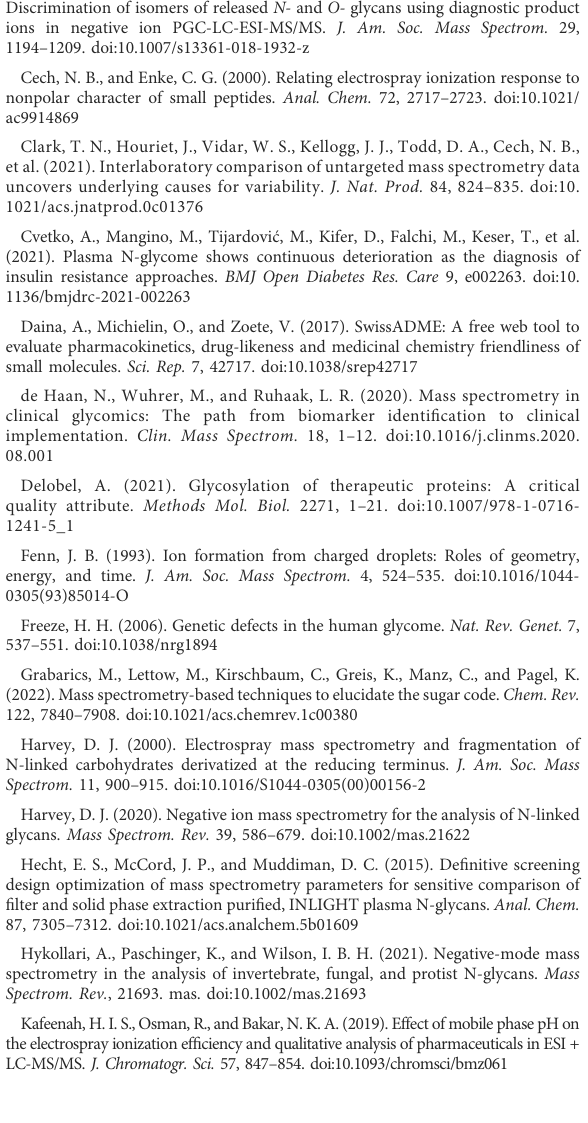
SUPPLEMENTARY FIGURE S2 Fluorescence signal to noise ratio of all the labels. SUPPLEMENTARY FIGURE S3 Extracted ion chromatogram of labeled and unlabeled FA2 glycan for (A) 2AA and (B)